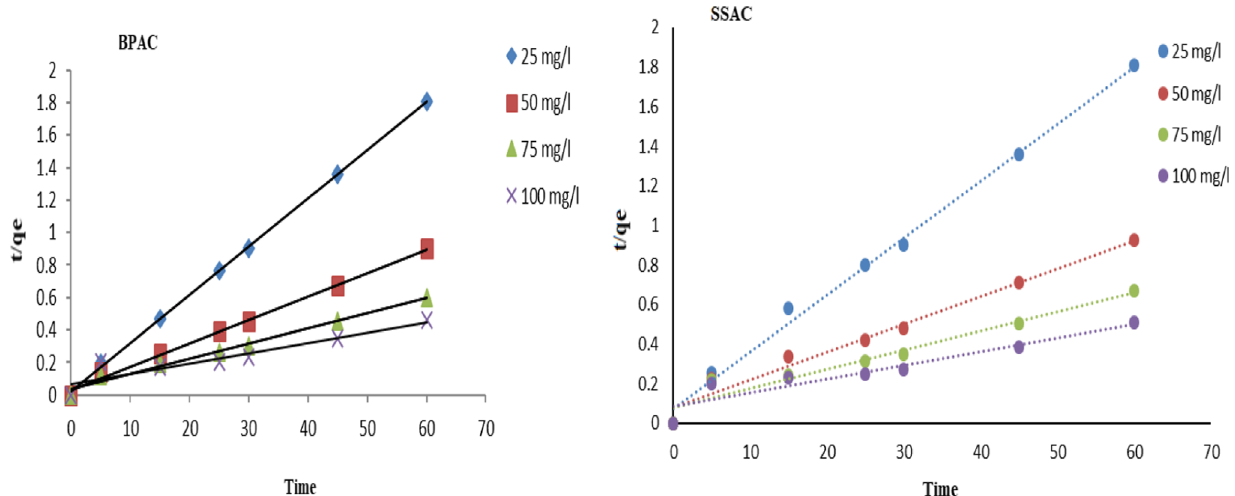
Fig 11 Pseudo-second kinetic data of adsorption by BPAC and SSAC